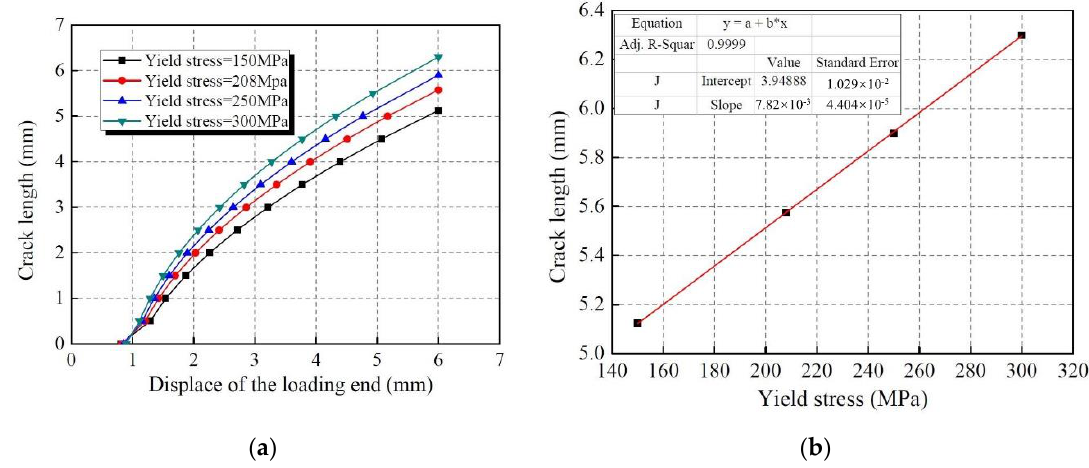
Figure 21. ( a ) Effect of yield strength on crack length; ( b ) fitting relationship between crack length and yield strength.